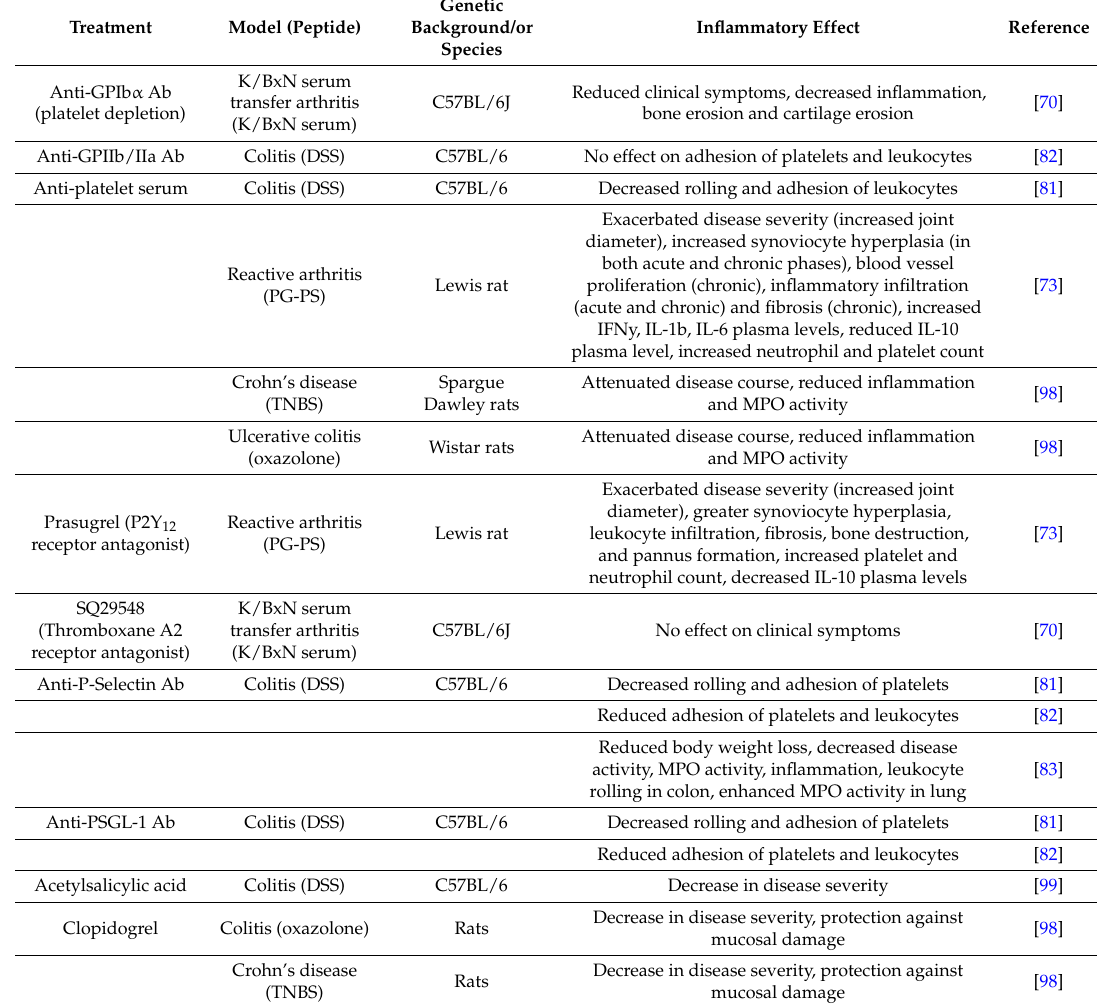
Table 4. Studies of platelets and platelet-derived factors: effects on inflammatory processes using pharmacological